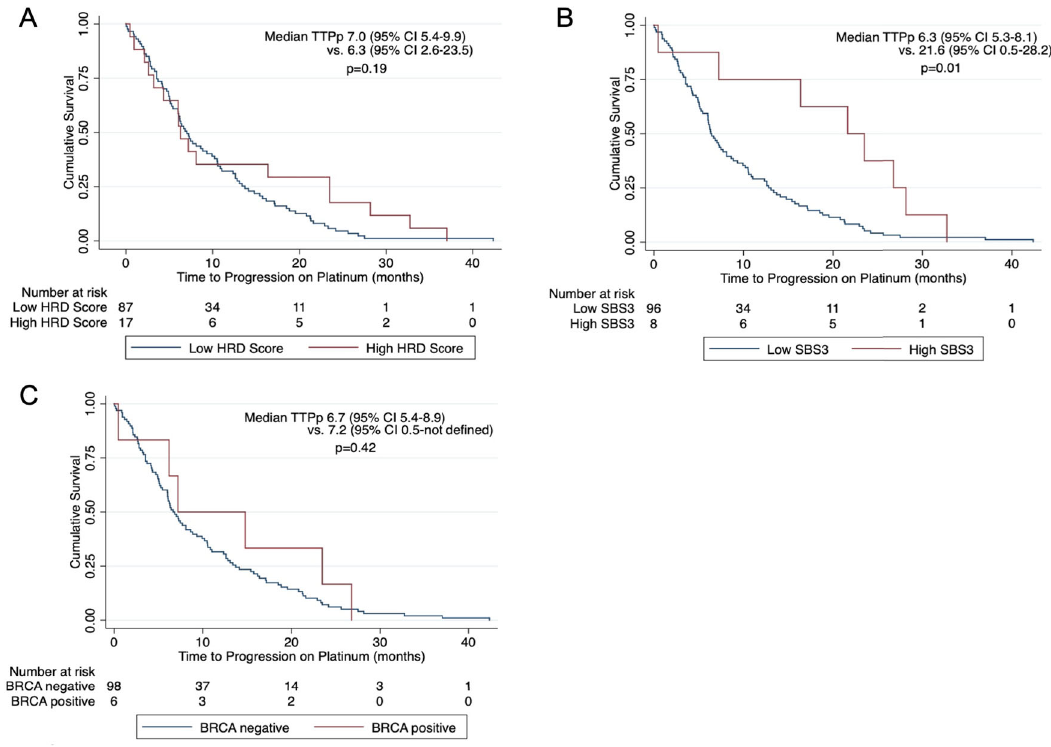
Fig. 4 Kaplan – Meier time to progression on platinum curves for patients with metastatic gastrointestinal malignancies. Curves are strati fi ed by HRD score ( A ), SBS3 exposure ( B ), and BRCA status ( C